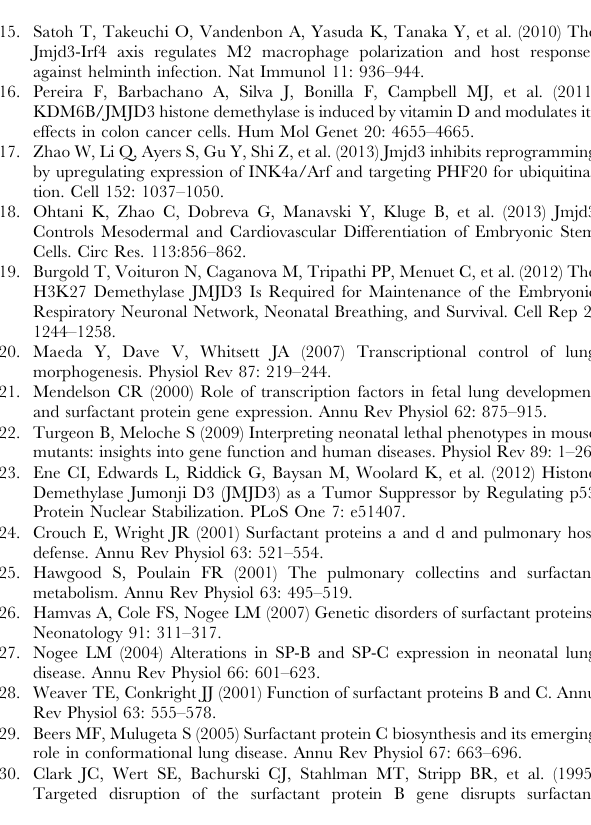
Figure S7 Catalytic domain of Jmjd3 is required for enhancing SP-B-promoter-driven luciferase activity. Up, the measurement of